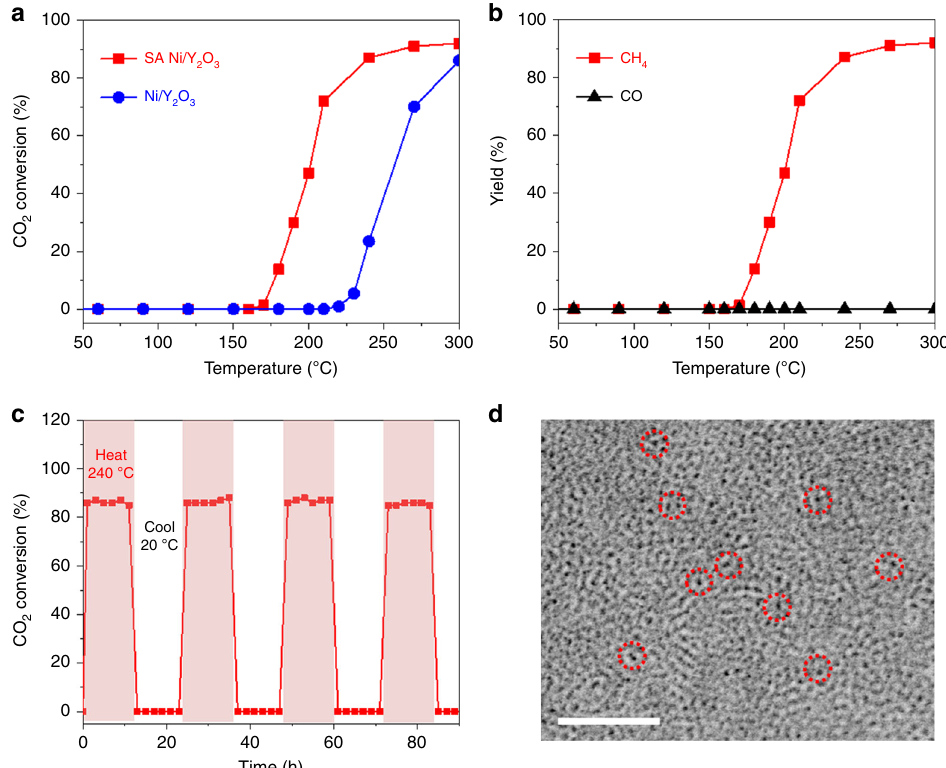
Fig. 4 Thermocatalytic CO 2 hydrogenation experiments. a Thermal CO 2 conversion using the SA Ni/Y 2 O 3 nanosheets (SA Ni/Y 2 O 3 ) and Ni nanoparticles/ Y 2 O 3 nanosheets (Ni/Y 2 O 3 ) as a function of temperature. b CH 4 and CO yields from the CO 2 hydrogenation over the SA Ni/Y 2 O 3 nanosheets as a function of temperature. c CO 2 hydrogenation versus reaction time over the SA Ni/Y 2 O 3 nanosheets at 240 °C. d Aberration-corrected TEM image of